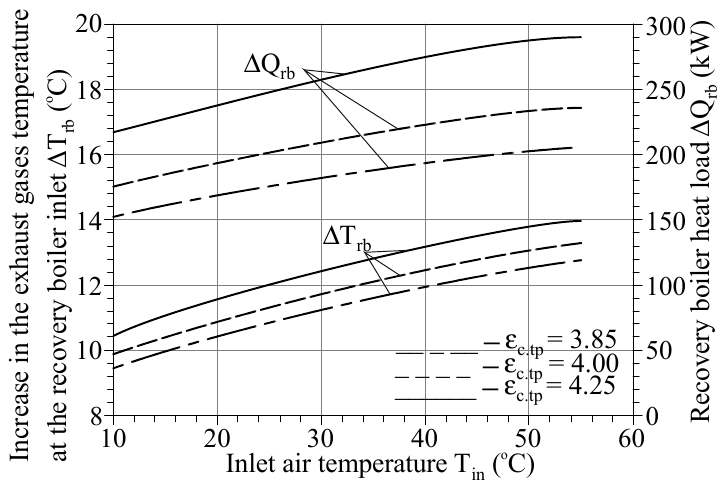
Figure 22. Dependences of the recovery boiler heat load, Δ Q rb ; an increase in the exhaust gases temperature at the recovery boiler inlet, ∆ T rb , at different total pressure increase, ε c.tp , on the inlet air temperature, t in .